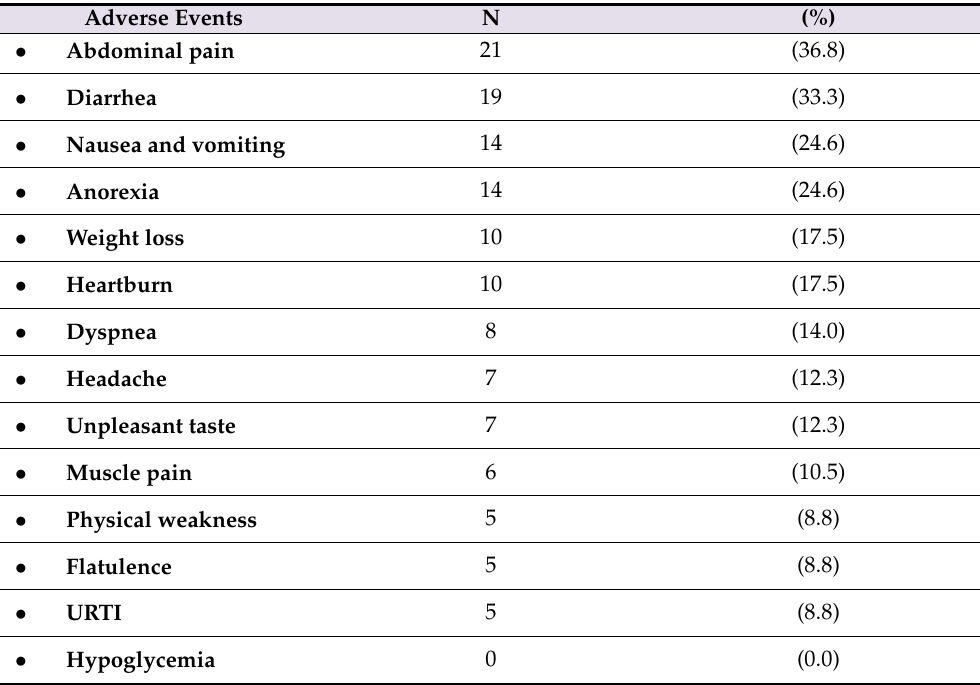
Table 5. Adverse effects in patients receiving metformin as an adjuvant to CTH (n = 57). Adverse